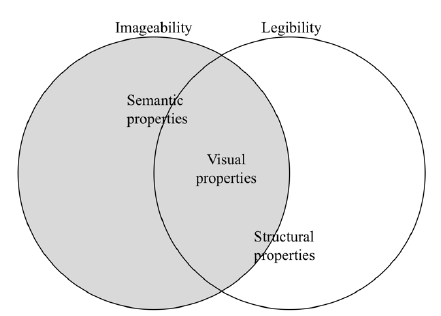
Figure 11. The relationship between imageability and legibility